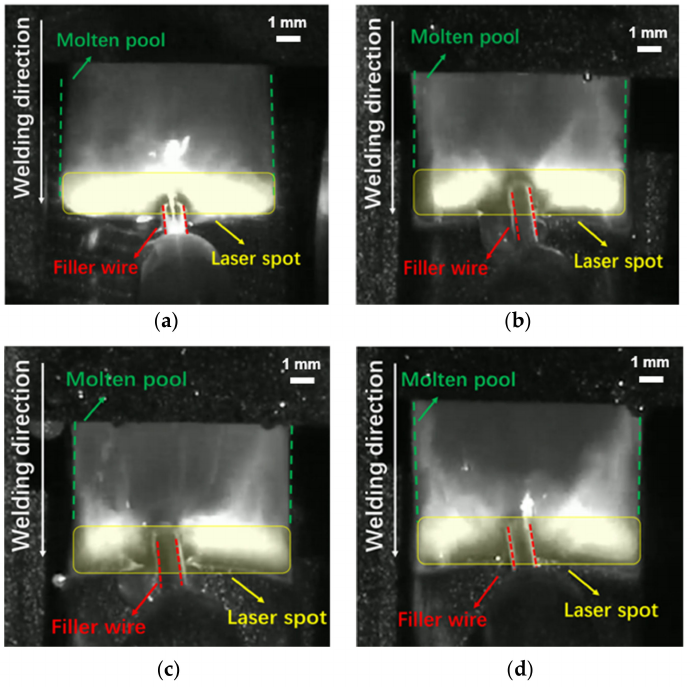
Figure 11. High-speed images on ( a ) first, ( b ) fifth, ( c ) tenth, and ( d ) fifteenth layer, during 15- layer